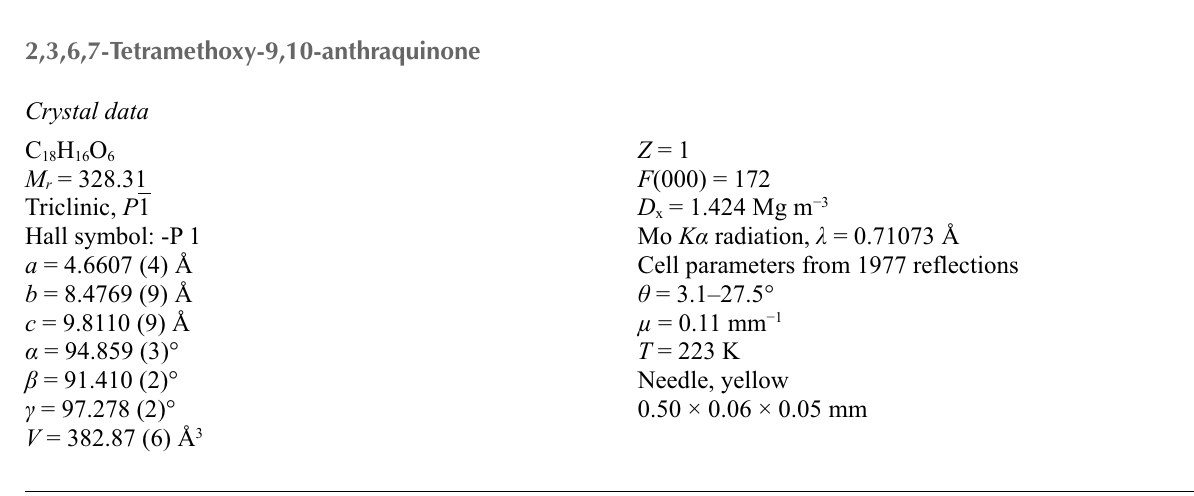
The packing diagram of (I). Hydrogen atoms are omitted for